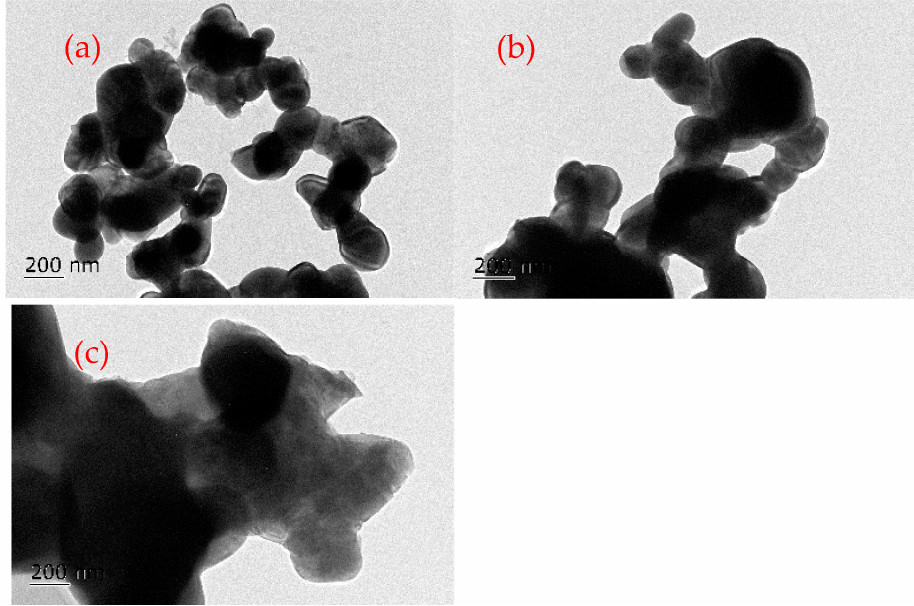
Figure 12. TEM photographs of the OC after different cycle numbers: ( a ) after 1 cycle, ( b ) after 5 cycles, ( c ) after 20 cycles.